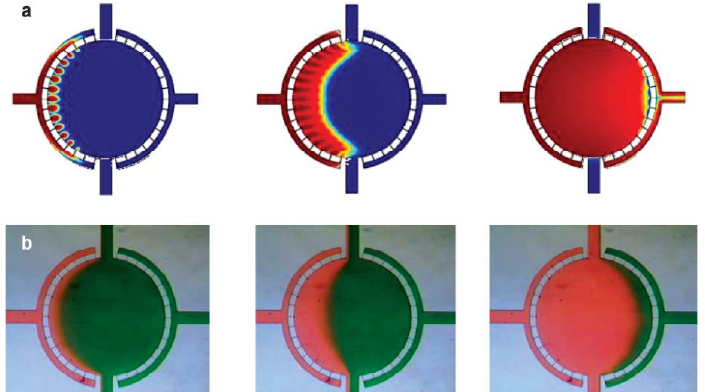
Figure 16. ( a ) Time-stepped computational fluid dynamics (CFD) simulation of fluid velocity; ( b ) time-stepped colored dye observation. Reproduced from